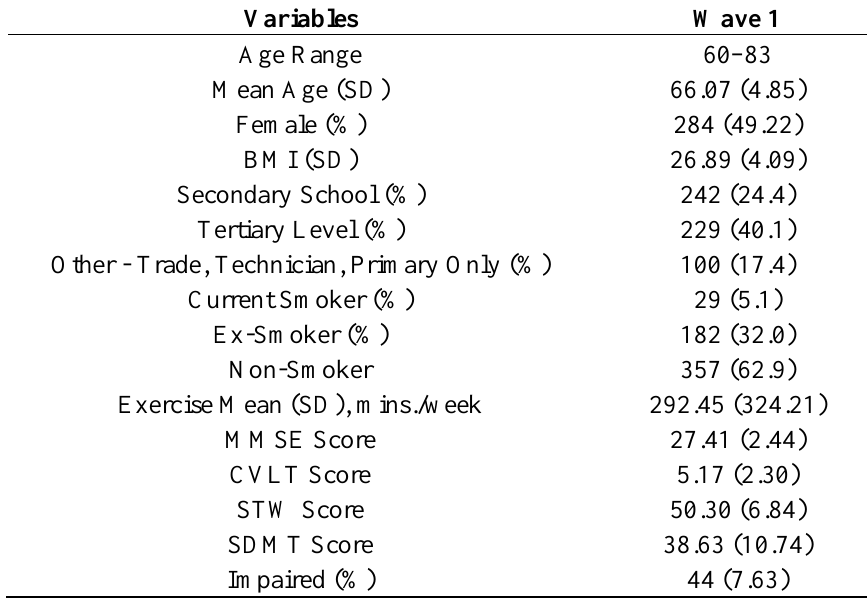
Table 2. Descriptive statistics at Wave 1 for the AusDiab sample included in the study ( n =